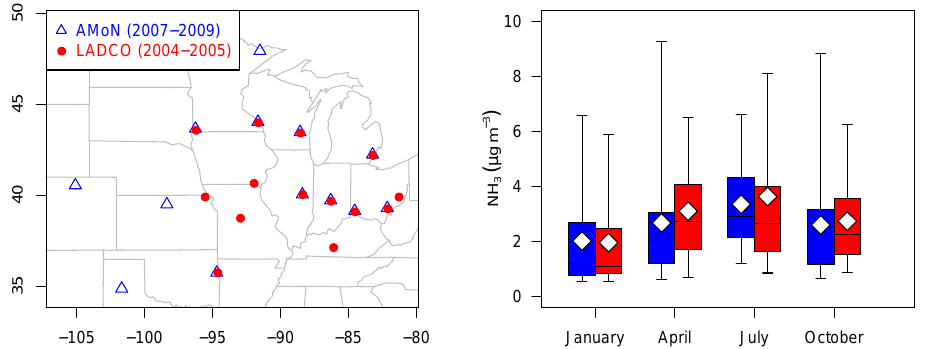
Fig. 17. Left: a map of measurement stations from the LADCO Midwest ammonia study (2004–2005) and the AMoN network (2007–2009). Right: box and whisker plot of monthly ammonia concentrations as measured at these monitoring networks, using the same notation as Fig. 15 and Fig.